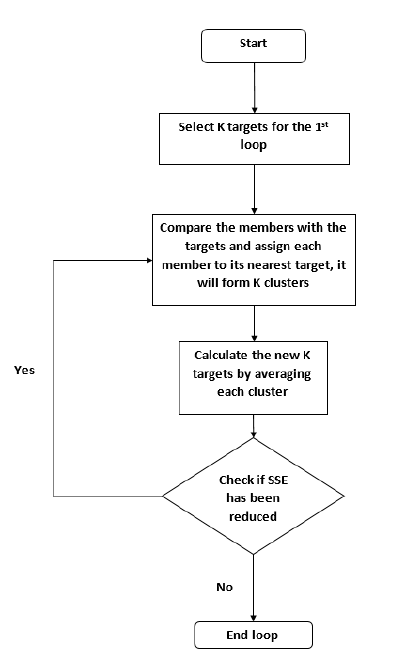
Fig. 1. Flow chart for K-means clustering